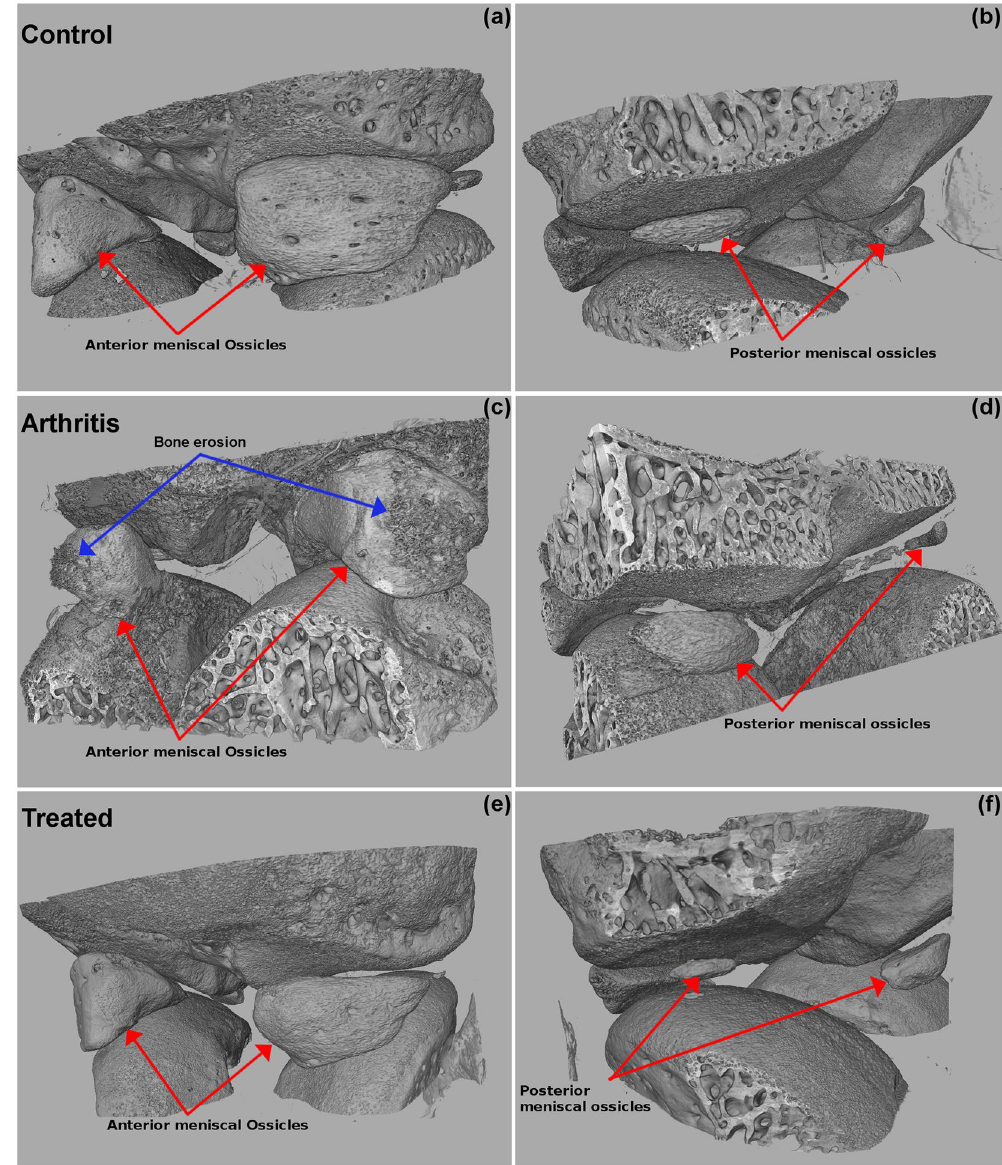
Figure 3. 3D structure of meniscal ossicles from image processing of micro-CT data. Representative images of contralateral joint ( control ), injected knee joint ( arthritis ) and injected knee joint after systemic treatment with Humira ( treated ) are shown from anterior view ( a , c , e ) and posterior view ( b , d , f